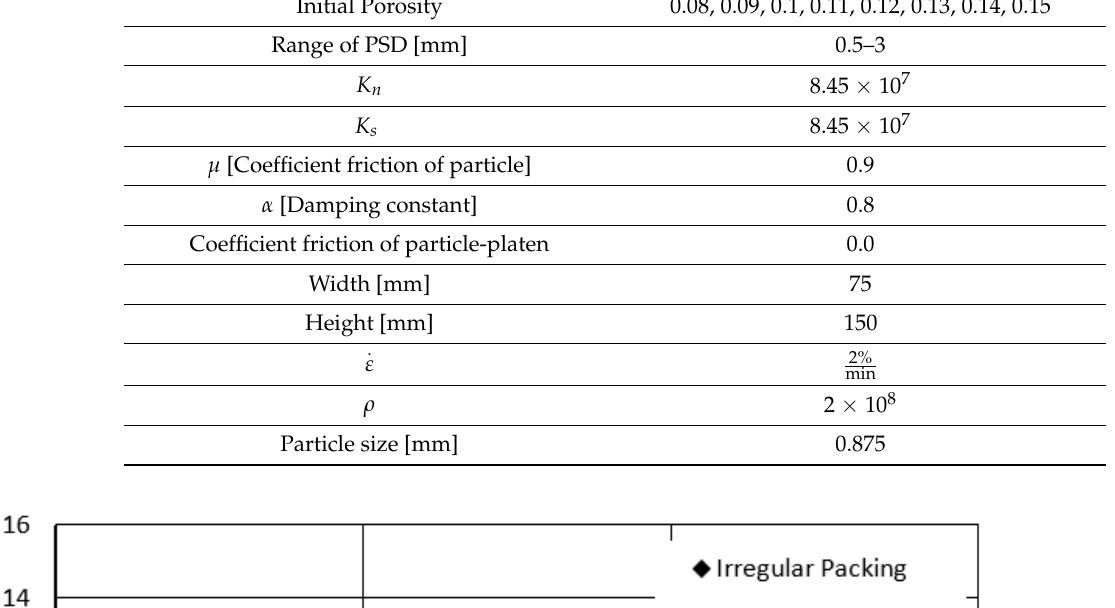
Table 3. The micro-mechanical properties of the hexagonal packing sample.